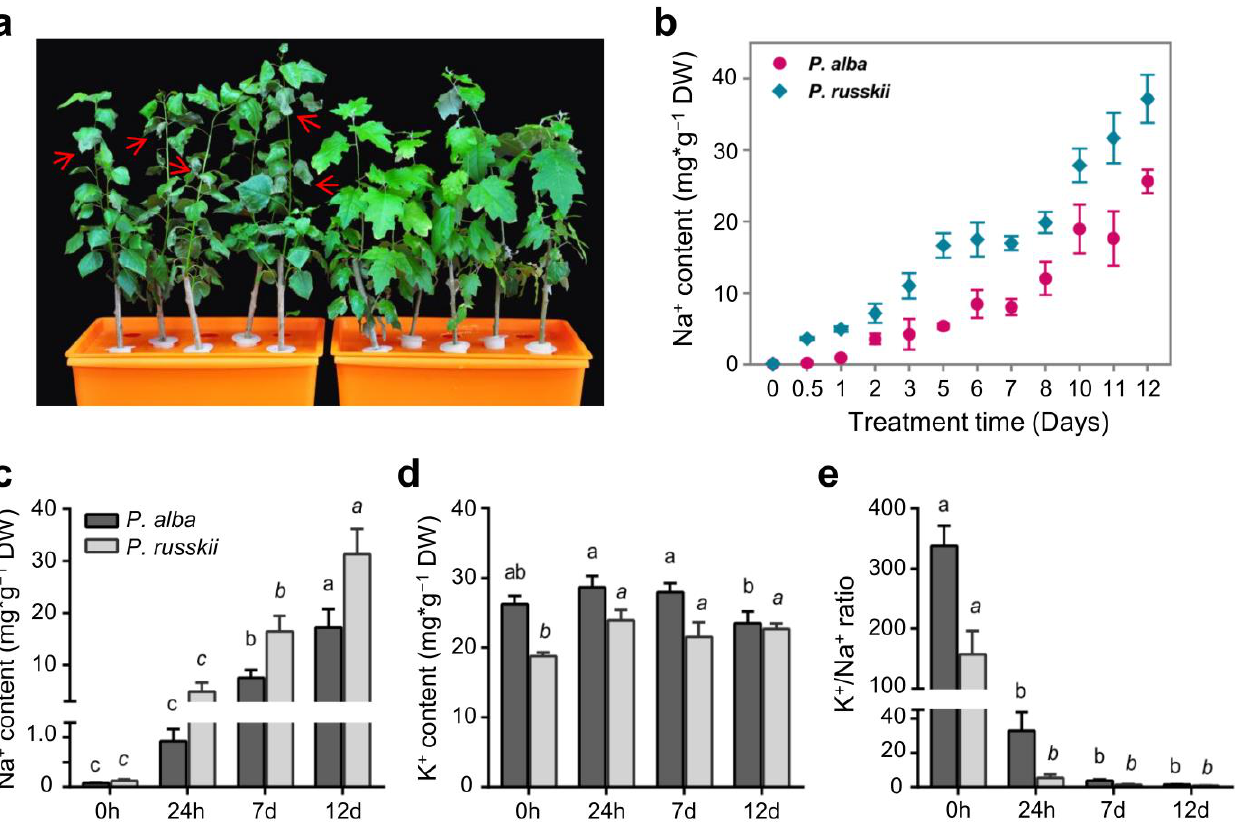
Figure 1. Phenotype and the content of Na + or K + in leaves of two Populus species under salt stress. ( a ) Morphological change of P. russkii ( left ) and P. alba ( right ) with 100 mM NaCl treatment for 12 days. Red arrows indicate the shrunken leaves of P. russkii . ( b ) Dynamic of Na + content in the two Populus leaves following NaCl treatment. ( c ) Na + content, ( d ) K + content, and ( e ) K + /Na + ratio in leaves of P. alba and P. russkii before treatment and after treatment for 24 h, 7 d, and 12 d. Data shown are the mean ± SD (n = 3). Different letters above the bars indicate the statistical significance at the p < 0.05 level among different time-points of NaCl treatment according to LSD